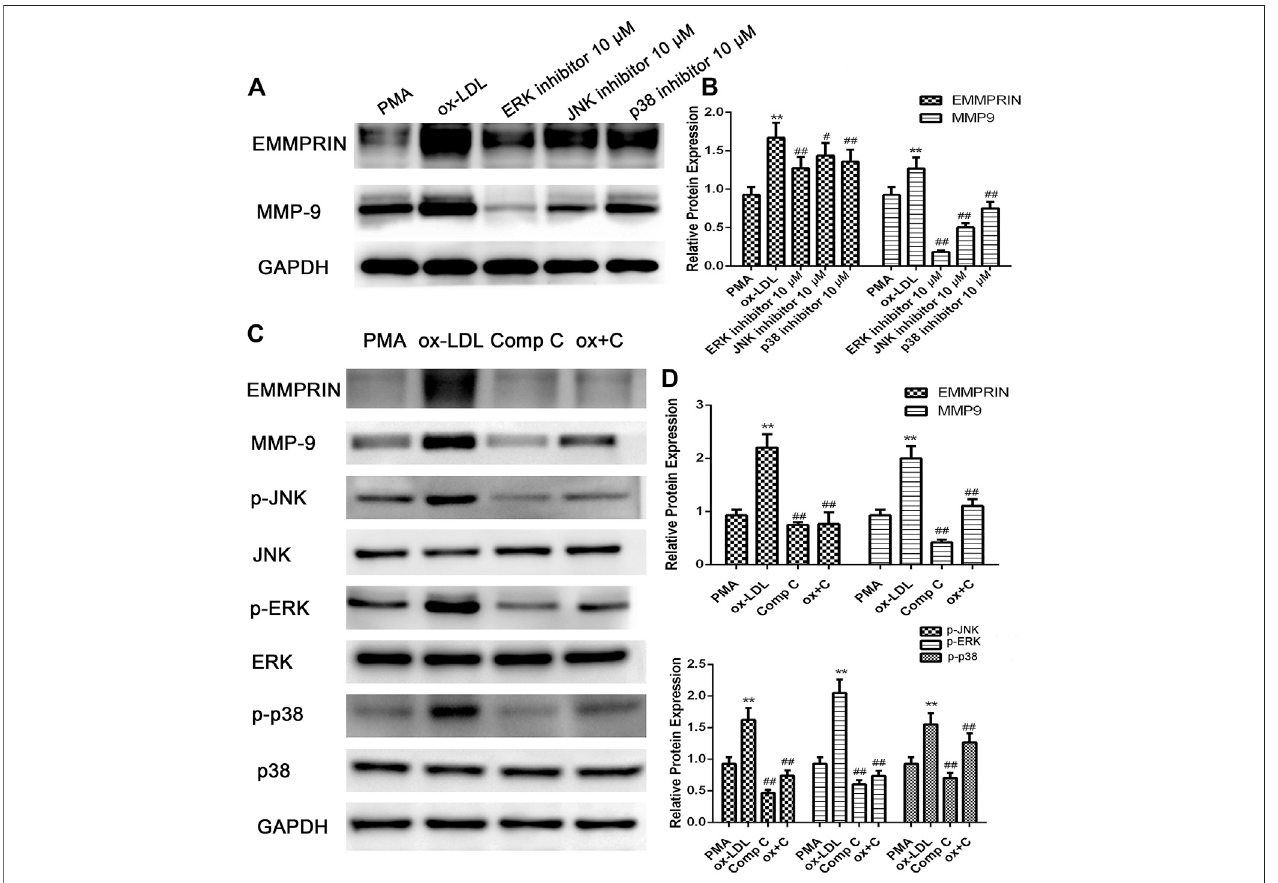
FIGURE2| oxLDL-induced EMMPRIN and MMP-9 expression inmacrophages isabolished byspeci fi cERK, JNK,and p38 inhibitors orcompound C.EMMPRIN and MMP-9 protein levels or phosphorylation of ERK1/2, p38, and JNK were measured by Western blotting. Densitometry measurements of phosphorylated ERK1/2, p38, and JNK were normalized to total ERK1/2, p38, and JNK, respectively. The band densities were measured by Quantity One 1D analysis software. The Data (means ± SD) were obtained from three independent experiments. ** p < 0.01 compared with PMA, # p < 0.05, ##: p < 0.01 compared with the oxLDL group.